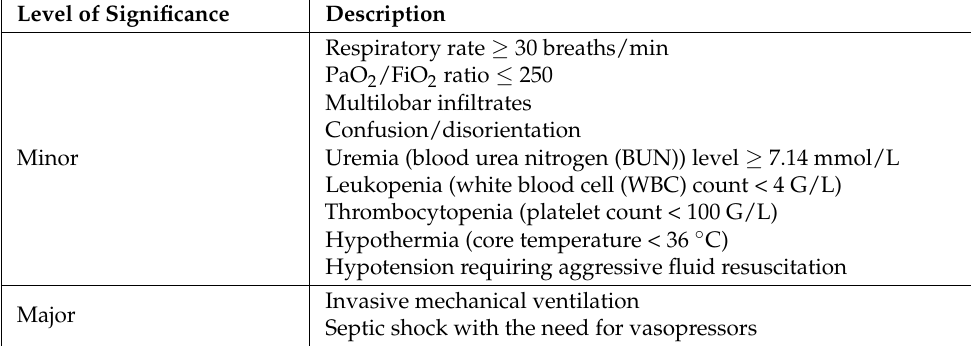
Table 1. Criteria of diagnosing community-acquired pneumonia